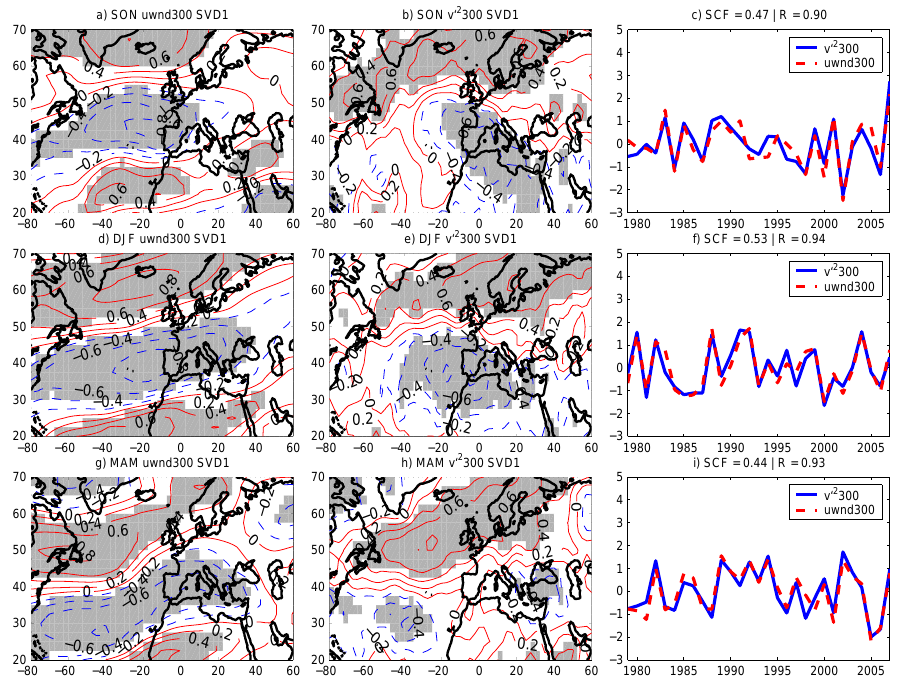
Fig. 2. Heterogeneous correlation maps of the 1st SVD mode (SVD1) between zonal wind (a, d, g) and stormtrack (b, e, h) at 300hPa, and related expansion coefficients (c, f, i) : in fall (upper panels), in winter (middle panels) and in spring (bottom panels). Positive values in red, negative values dashed in blue, 95% significance shaded in gray.